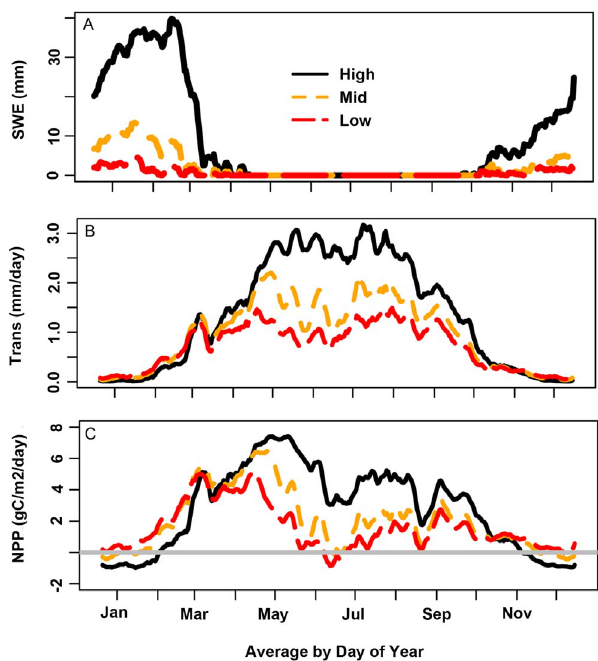
Figure 3. RHESSys estimates ecohydrologic fluxes for simula- tion period Graphs show a) snow water equivalent (per area of 30 m grid cell) for high, mid and low elevation site for water year 1992 – 2007 simulation period b) daily transpiration per grid cell, averaged by day of water year for pre-drought (1985 – 2000) period and c) daily net primary productivity (NPP) per grid cell, averaged by water year for pre-drought (1985 – 1999) period.